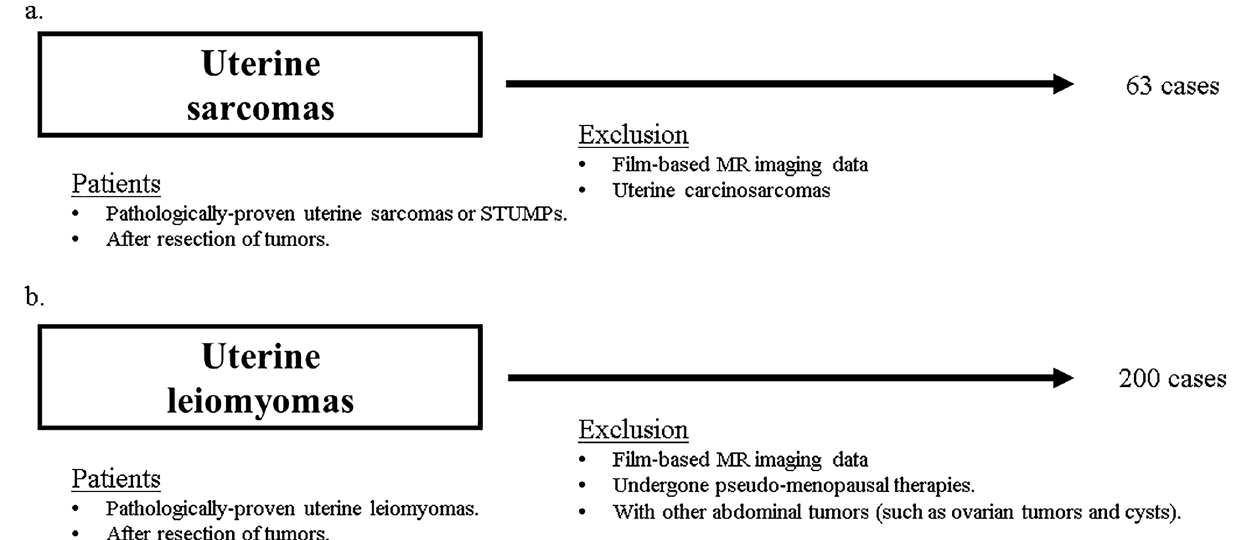
Figure 3. Study flow of patients. ( a ) Sixty-three cases of uterine sarcomas, including smooth muscle tumours of uncertain malignant potential (STUMPs), were included. The study excluded film-based MR images and carcinosarcomas. ( b ) Two-hundred cases of uterine leiomyomas sarcomas were included. The study excluded film-based MR images and patients who had undergone pseudo-menopausal therapies within 3 years or had other coexisting abdominal